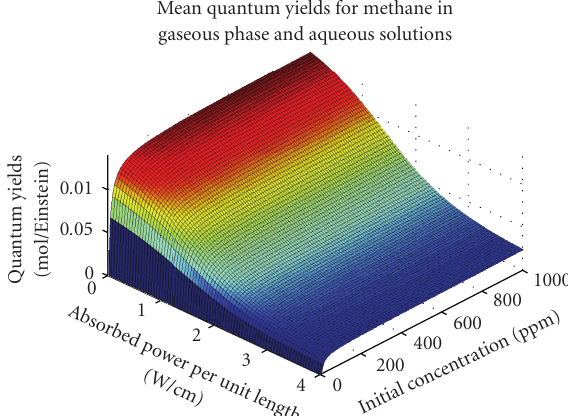
Figure 6: Quantum yields Φ 0 (mol of methane/Einstein) for pho- tomineralization of methane, as a function of initial concentration C 0 , expressed as mg/L of carbon, and of absorbed power per unit length of lamp (and membrane), expressed asW · cm − 1 . Quantum yields are expressed as means of values, from experiments in gaseous phase and in aqueous solutions. Photocatalytic membranes used in these experiments did not contain any photopromoting